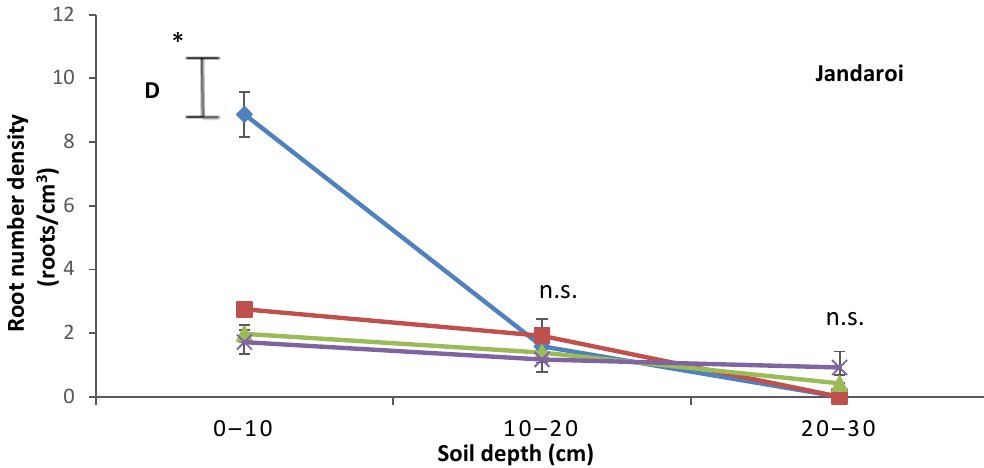
Figure 3. Changes in ( A , B ) root length density and ( C , D ) root number density with soil depth in salt-tolerant (Janz) and salt-sensitive (Jandaroi) wheat cultivars in response to salinity, low P supply, and their interaction. Measurements were made at the end of the experiment (40 DAS). Values are the means ± SE of three replicates (nine plants). The vertical bars represent the least significant difference value at p = 0.05 * and n.s., non-significant.